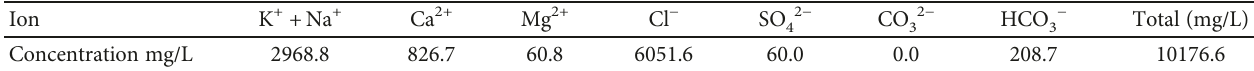
Table 1: Brine components.